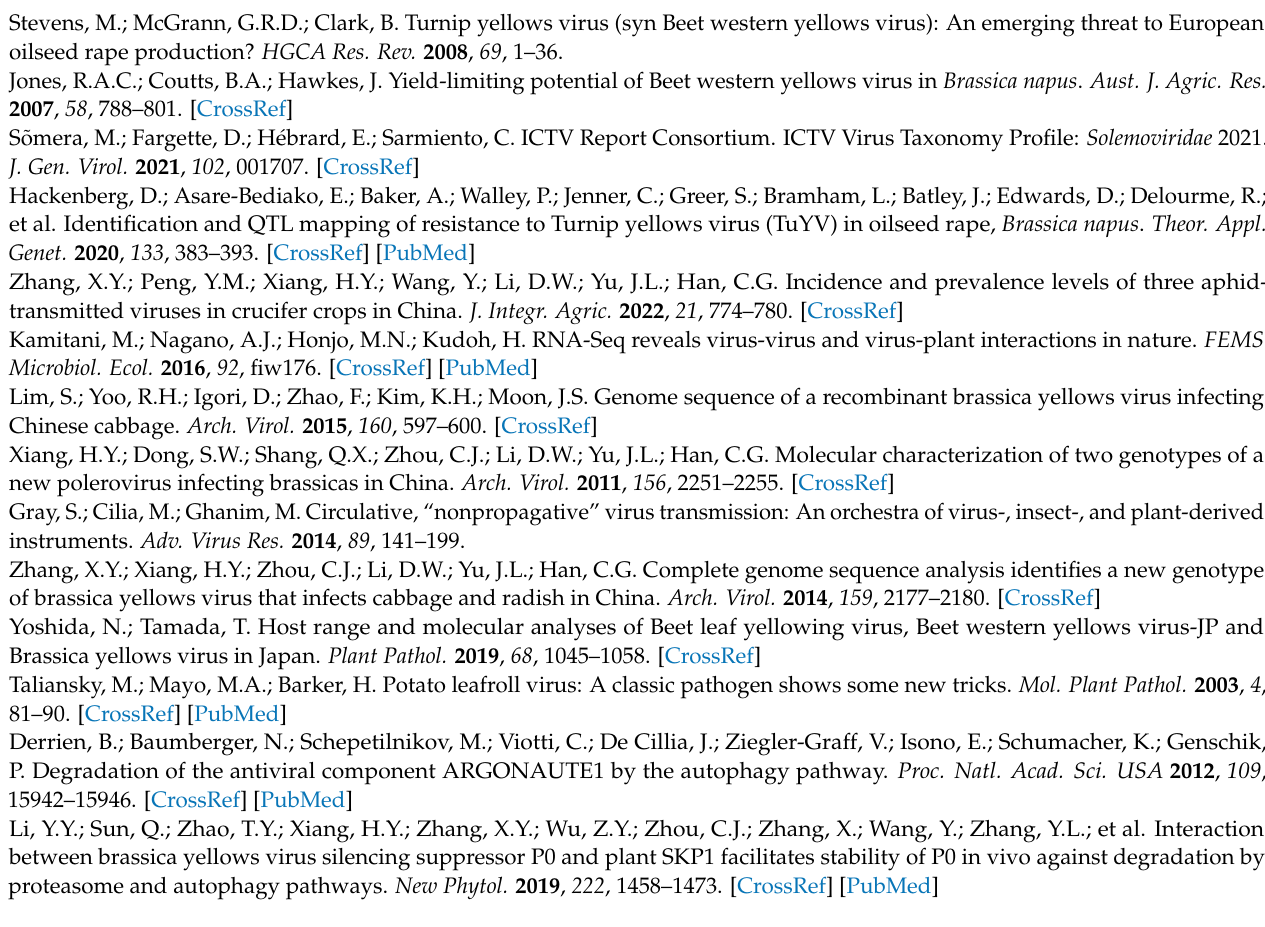
five fields; Figure S3. Pairwise analysis of BrYV coding proteins; Figure S4. The RDP method plots of 7 recombinants among BrYV and TuYV isolates; Figure S5. The electrophoretogram of RT-PCR analysis against